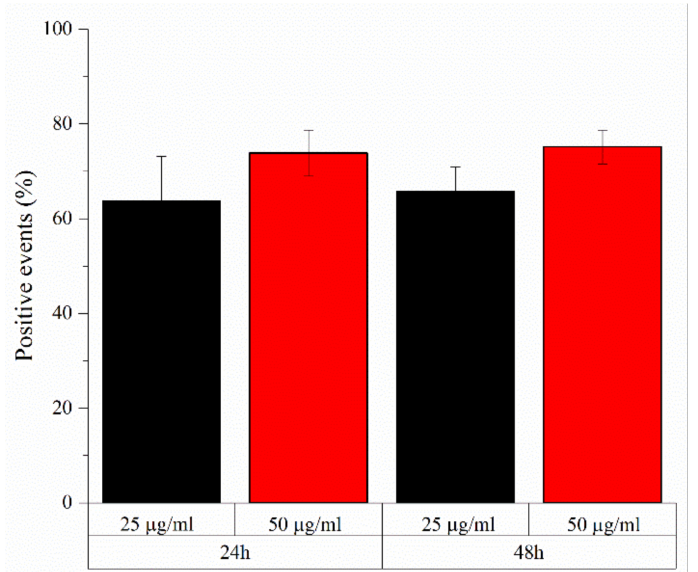
Figure 4. a-TiO 2 -NH 2 /BSA NPs internalization on Daudi cells incubated for 24 h and 48 h with different NPs concentrations (25 and 50 µ g/mL). Bars represent the percentage of positive event with respect to the control cells ± SEMs, n = 3.